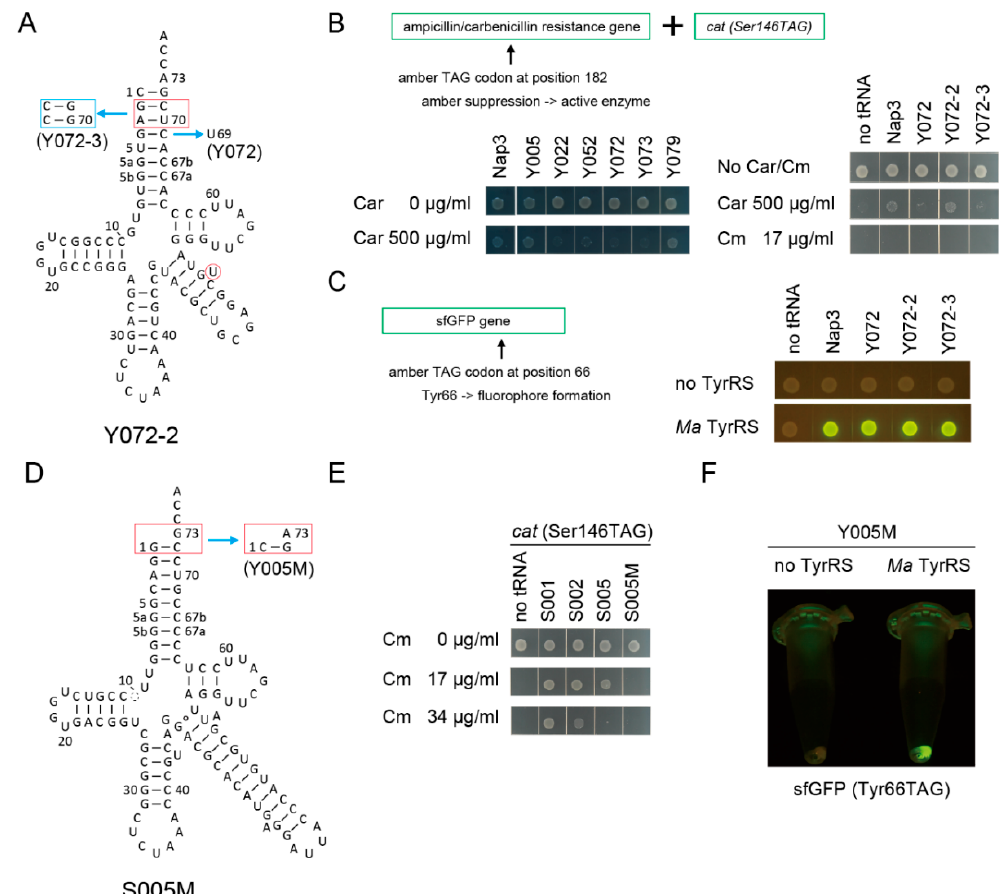
Figure 5. Development of synthetic tyrosine tRNAs using candidate tRNA chassis. ( A ) The cloverleaf structure of Y072-series tRNA variants. ( B ) The S072 and S073 variants conferred only marginal carbenicillin (Car) resistance (less than Car 500 µ g / mL) to E. coli DH10B cells expressing the bla(Ala182TAG) reporter gene and the cat(Ser146TAG) reporter gene in the absence of any heterologous TyrRS enzyme. Amber suppressor variants of archaeal M. jannaschii tRNA Tyr species (Nap3) and the Y005, Y079, and Y072-2 variants conferred up to 500 µ g / mL Car resistance, indicating that these tRNAs were to a less extent charged by endogenous aaRSs. No Cm resistance was introduced by the Y072, Y072-2, and Y072-3 variants, indicating that they were orthogonal to SerRS. ( C ) In the presence of Ca. M. alvus TyrRS in E. coli DH10B, the Nap3 variant and the three Y072-series variants translated the amber codon in the sfGFP(Tyr66TAG) reporter gene with tyrosine, making the fluorophore of sfGFP. ( D ) The cloverleaf structure of the S005M and Y005M tRNA variants. ( E ) The S005M variant conferred a lower Cm resistance (less than Cm 17 µ g / mL) to E. coli DH10B cells expressing the cat(Ser146TAG) reporter gene compared to the S002 and S005 variants. ( F ) In the presence of Ca. M. alvus TyrRS in E. coli DH10B, the Y005M variant translated the amber codon of the sfGFP(Tyr66TAG) reporter gene with tyrosine, making the fluorophore of